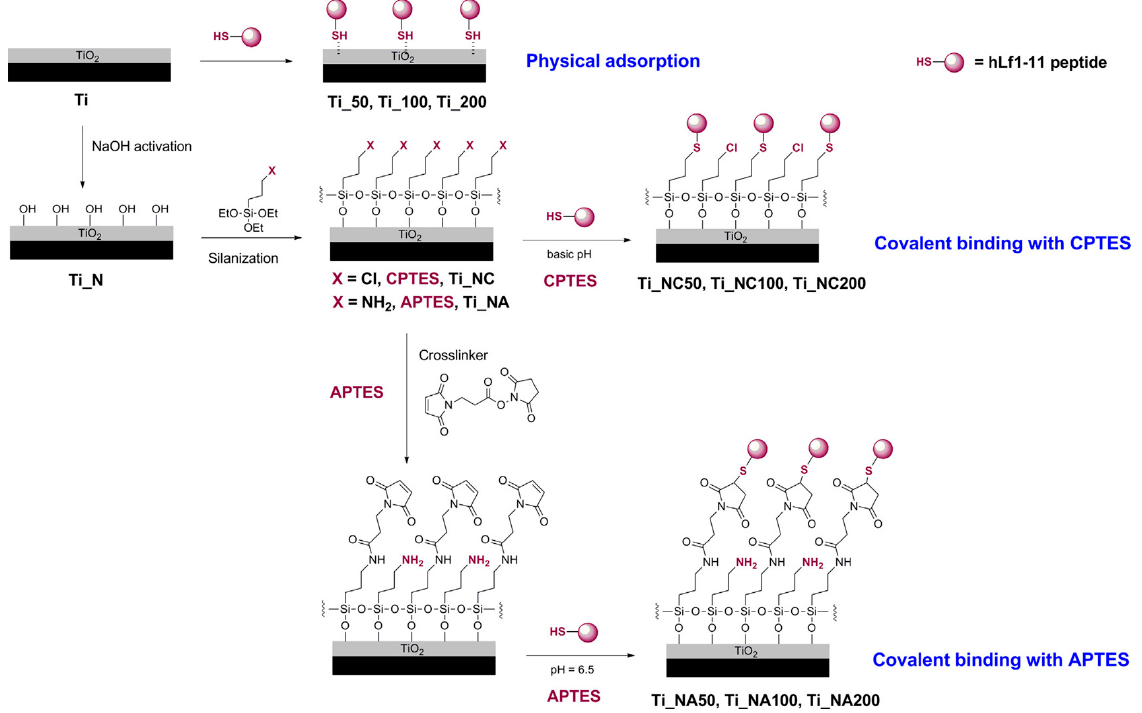
Figure 19. Functionalization strategies to anchor the hLf1-11 peptide to titanium: physical adsorption and covalent binding with CPTES or APTES. Adapted from [85]. Copyright © 2014 Acta Materialia Inc. Published by Elsevier Ltd. All rights reserved.